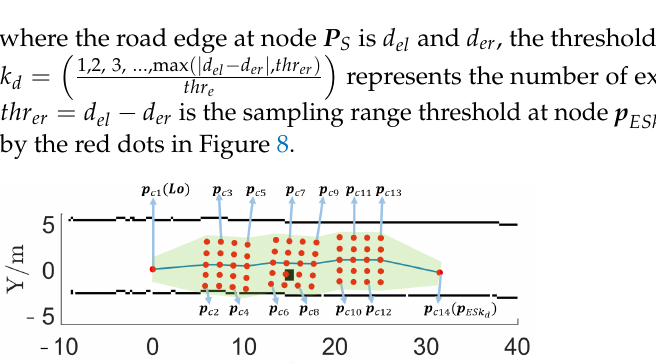
Figure 8. An example of P E .